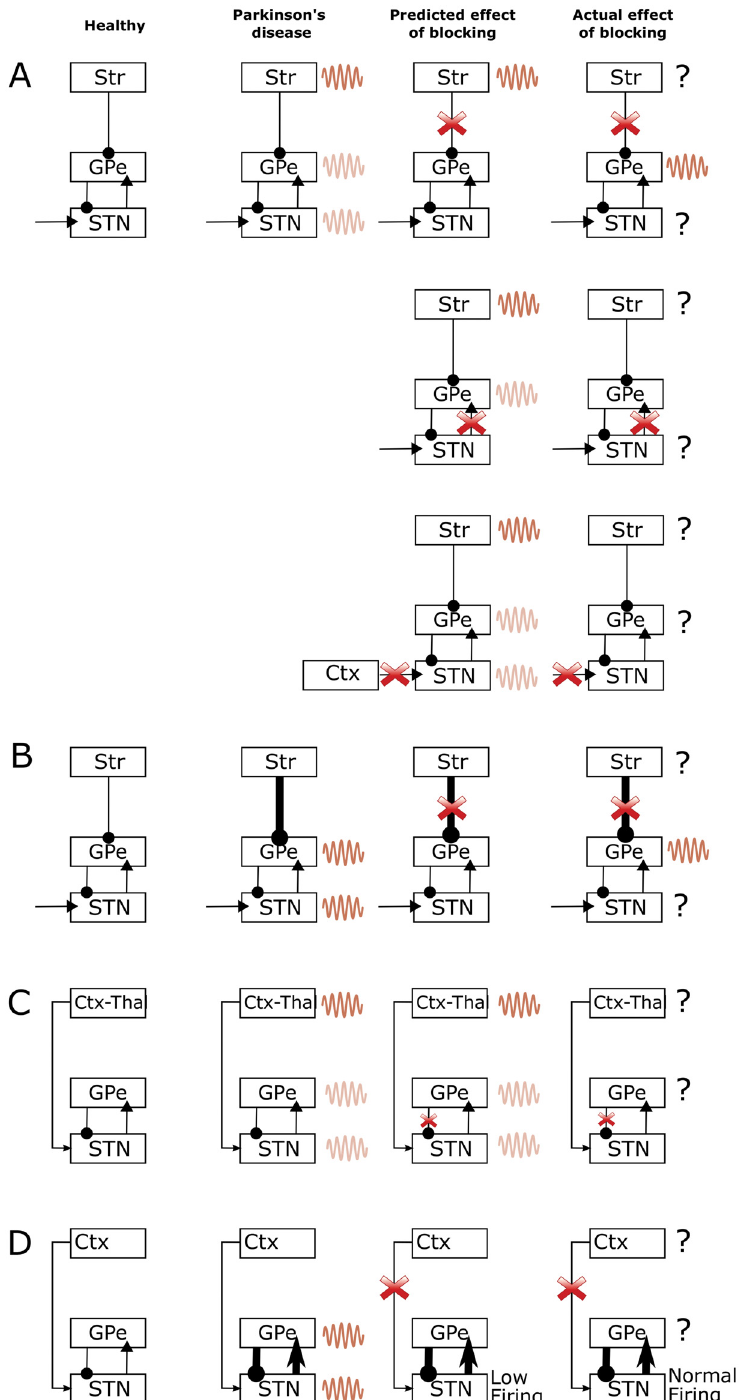
Fig 2. A graphical illustration of four alternative theories for the generation of beta oscillations in the cortical-basal ganglia circuits, the predicted effects of blockade from models and actual effects of blockade of connections reported in Tachibana et al. [14]. The first column shows the non-pathological state in healthy controls, the second column shows what the corresponding theories suggest happens in the Parkinsonian state, the third column shows the predicted effect of blockade of connection and the fourth column shows the actual effect of blocking from Tachibana et al. [14]. Note that oscillations in certain areas are not reported by Tachibana et al. [14], therefore in the fourth column this is illustrated by a question